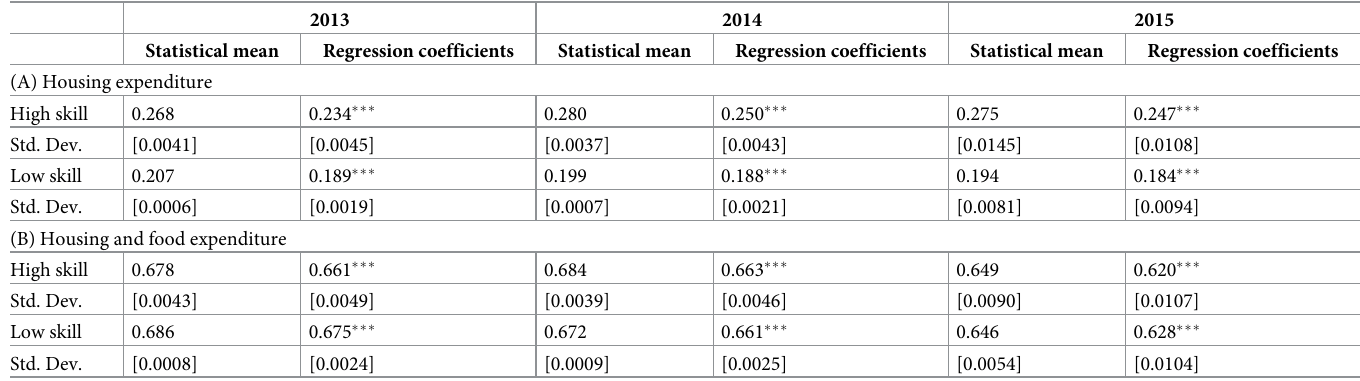
Table 4. Local good expenditure share for high- and low-skilled labor from 2013 to